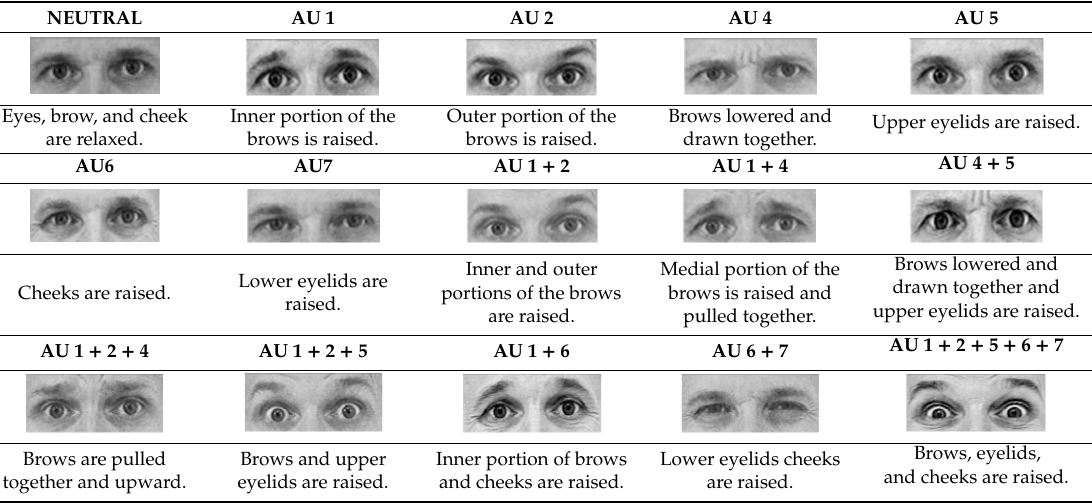
Table 2. Upper face action units and some combinations.